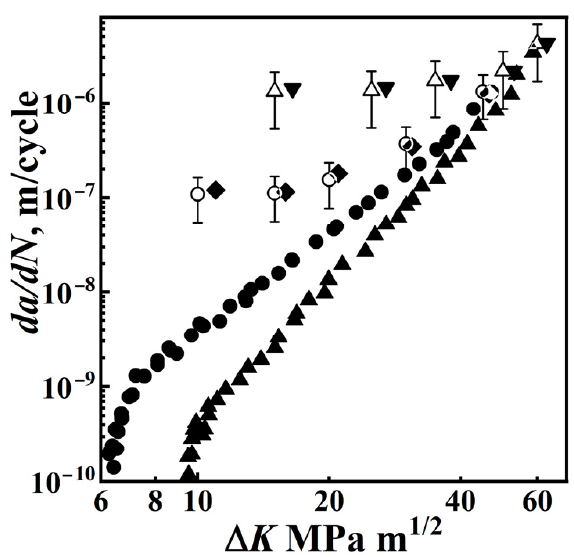
Figure 8. Macroscopic FCG rate da/dN depending on the values of the SIF range ∆ K for 34KhN3M steel in the initial state (black triangles) and after ~ 3 × 10 5 h of operation in the rotor disk of a steam turbine (black circles). The scattering bands of the values of microscopic FCG rate and its average values (white triangles and circles correspond to the steel in the initial state and after long-term operation) were obtained using the proposed method of estimating the distance between fatigue striations on digital fractographic images. All values of the microscopic FCG velocity within each of the scatter bands were obtained at the same value of the SIF range. The values of the microscopic FCG velocity for steel in the initial state and after operation, determined from the manually measured spacing of the fatigue striations, are shown by black inverted triangles and rhombuses, respectively. Measurements of the FS spacing were carried out manually using fractograms ob- tained during SEM studies of fracture surfaces of both steel variants. These fractograms were recorded at five levels of the SIF range and in five to seven areas located at a distance of up to 0.5 mm from each other. Taking into account the average values of the FS at each SIF level, the corresponding values of the microscopic FCG rates were plotted on the macroscopic FCG diagrams (Figure 8, black inverted triangles and rhombuses